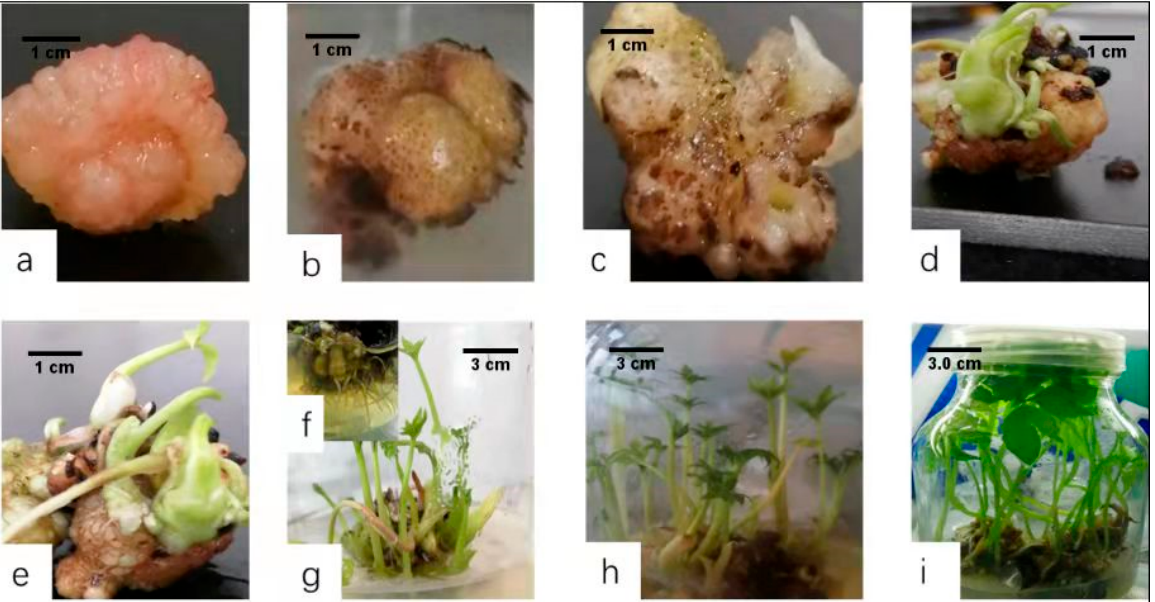
Figure 4. Embryogenic callus differentiation and shoot regeneration by one-step seedling formation system. ( a ) Type III embryogenic callus. ( b ) Fifteen days after transfer, the volume of the embryogenic callus increased. ( c ) Micro-corm formation after 30 days. ( d ) Micro-corm germination after 45 days. ( e ) Multiple shoots formed on the surface of the micro-corm, and adventitious roots began to grow after 50 days. ( f ) Plants increased after 55 days of culture. ( g ) Zoomed-in view showing many adventitious roots in the lower part of the micro-corms. ( h , i ) Clusters after 65 days and 70 days of culture,